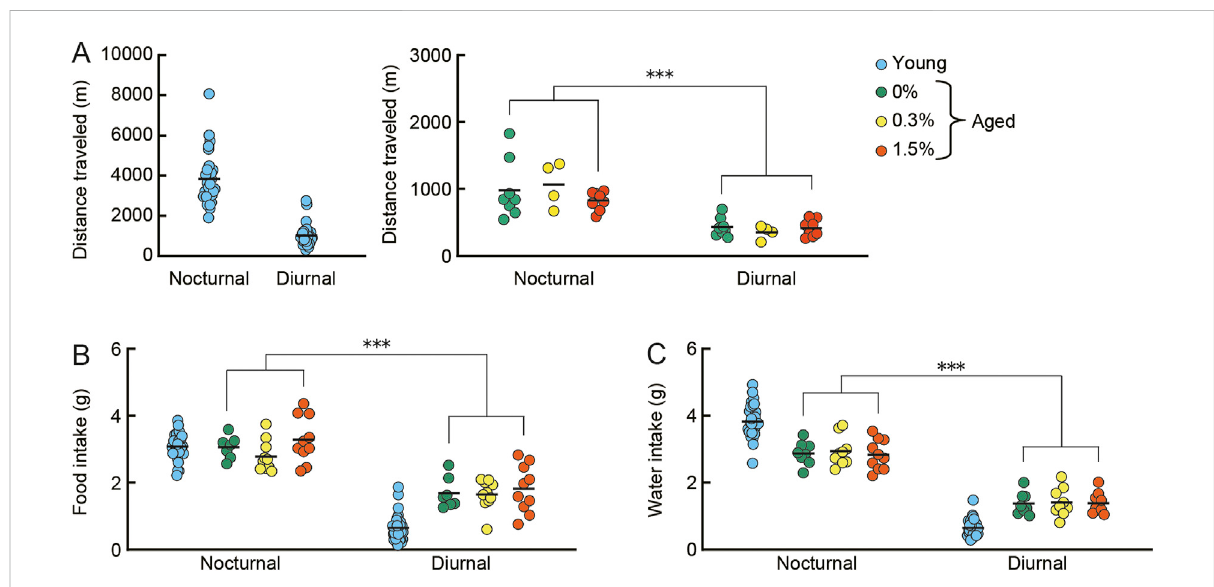
FIGURE 2 Cilostazol has no effect on spontaneous home-cage activity, food intake, and water intake. Young mice were 3 months old ( n = 32), and aged mice were 23 months old ( n = 28). Eight (control) to ten (0.3 and 1.5% cilostazol) aged mice were used for the home-cage observations. Scatter dot plot representing spontaneous activity, i.e., distance traveled (A) , food intake (B) , and water intake (C) on the sixth day for diurnal and nocturnal phases.Duetomarkeddifferencesindistancetraveledbetweenyoungandthreegroupsofagedmice,dataforyoungandagedmiceareshown in separate panels. Two-way ANOVA showed that the aged mice of the three dose groups became active during the nocturnal phase compared to the diurnal phase (distance traveled, p < 0.001). We observed the same pattern for food intake ( p < 0.001) and water intake ( p < 0.001). Cilostazol administration, however, had no signi fi cant effect on any of the indices. Data for young mice are for reference only; they were not included in statisticalanalysis.*** p < 0.001.Duetoequipmentfailure,activitydataforfourcontrol(0%)andtwoagedmicewerelost;dataforfoodintakeforone control (0%) mouse and data for water intake for one aged mouse (0.3%) were lost. Horizontal bars indicate mean